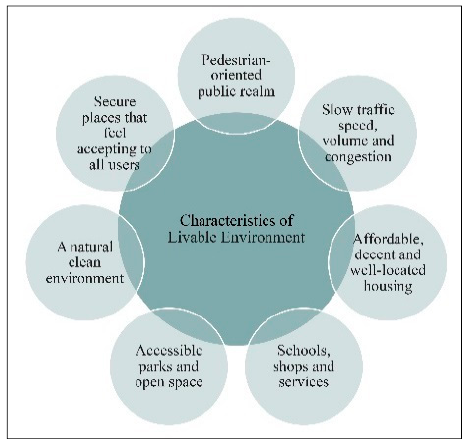
Figure 1. Characteristics of a livable environment (Source: the Authors).